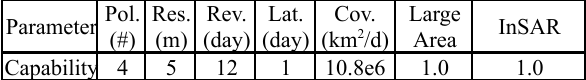
Table 6. Conservative capability estimate of L1A architecture for this analysis.